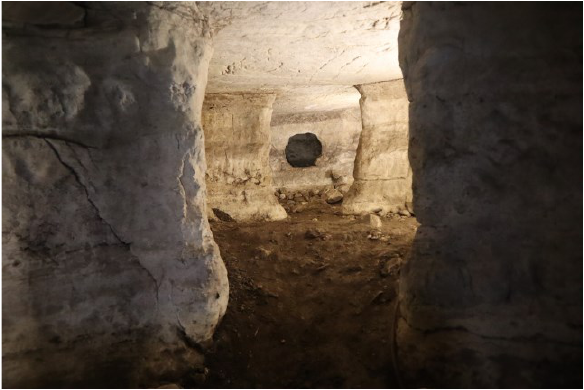
Figure 1 . Enfilade of rooms 19, 20,